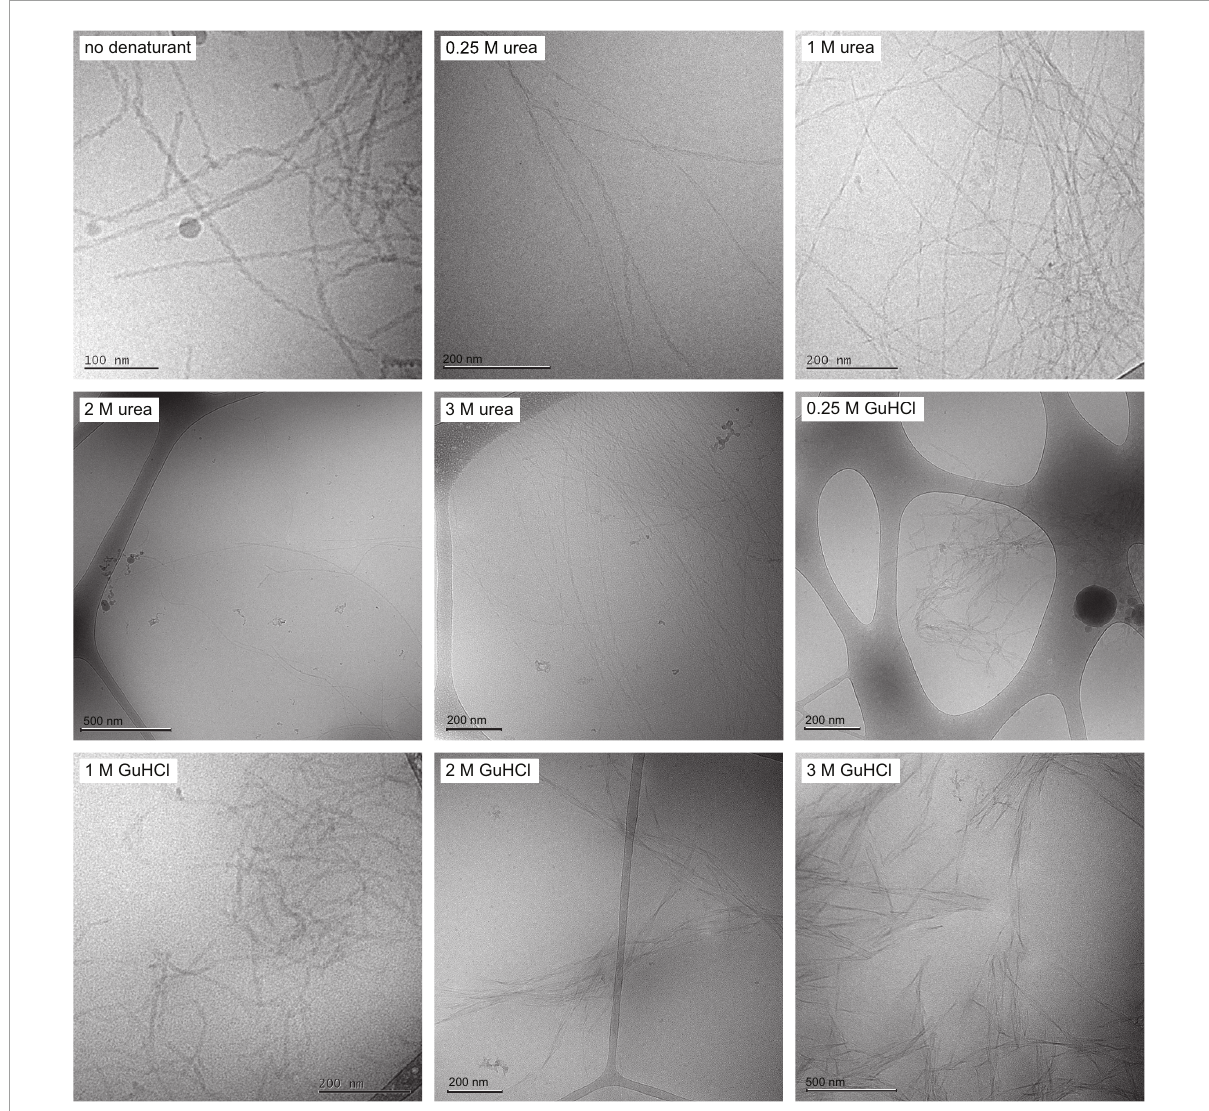
FIGURE1 Fibril morphology Cryo -TEM images with fibrils formed in the absence of denaturant, in 0.25, 1, 2, and 3 M urea and in 0.25, 1, 2, and 3 M GuHCl. Fibrils formed in urea are on average longer than fibrils formed in buffer. Fibrils formed in 1 M GuHCl have similar morphology to fibrils formed in buffer but are on average